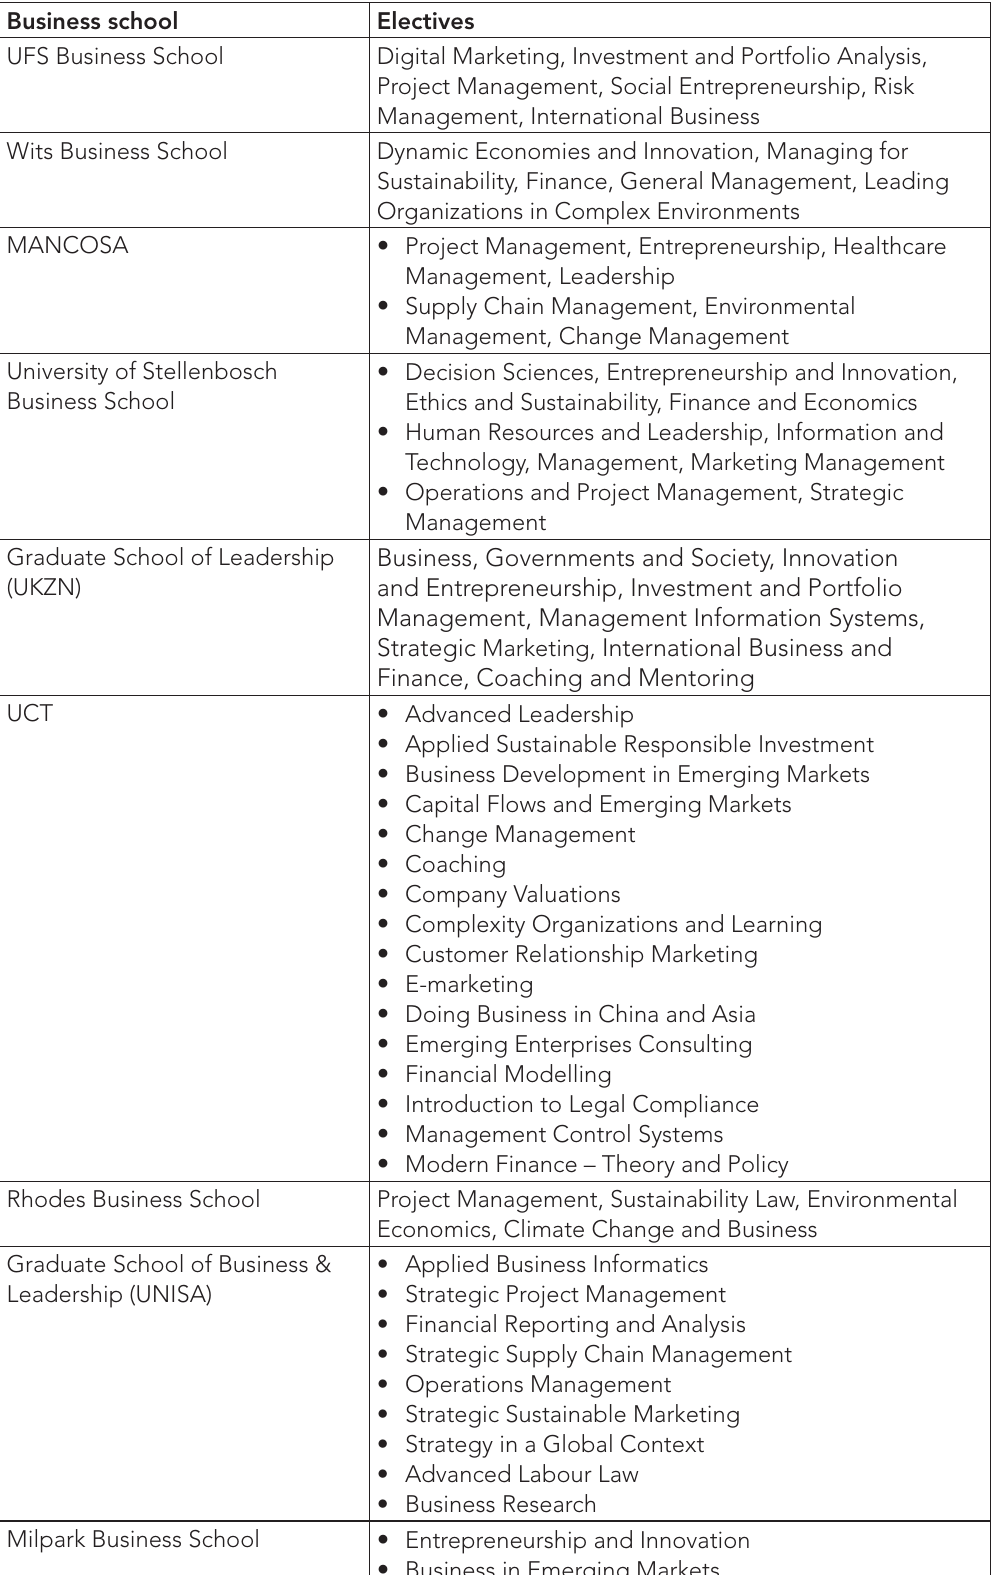
Table 8: Electives offered by South African business